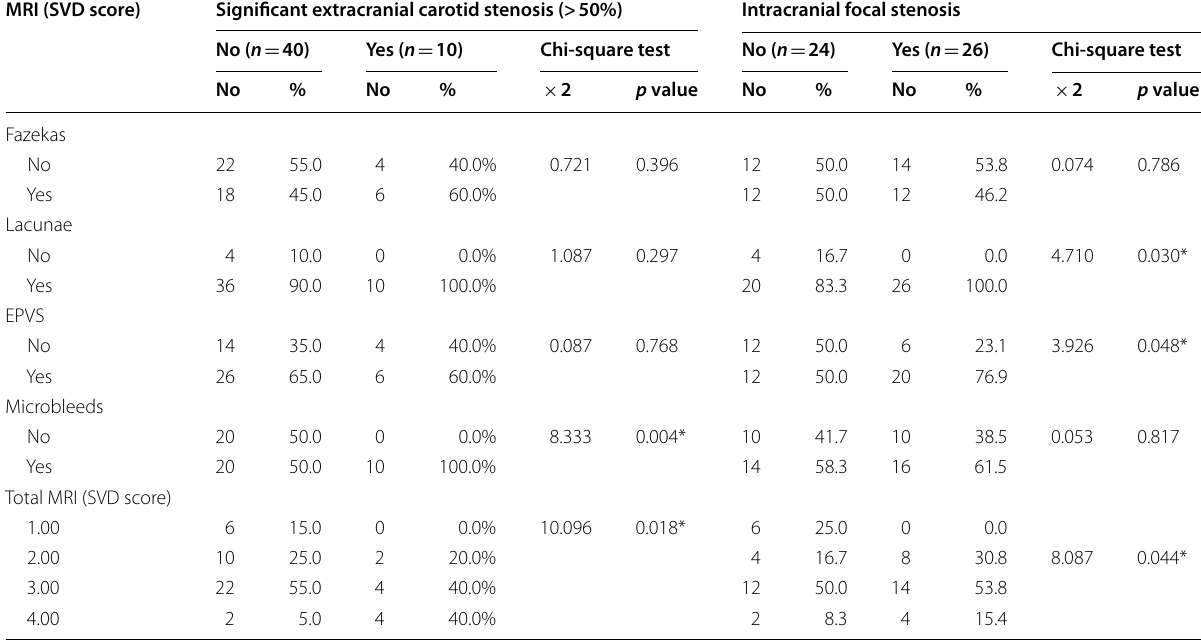
The asterisk denotes statistically significant